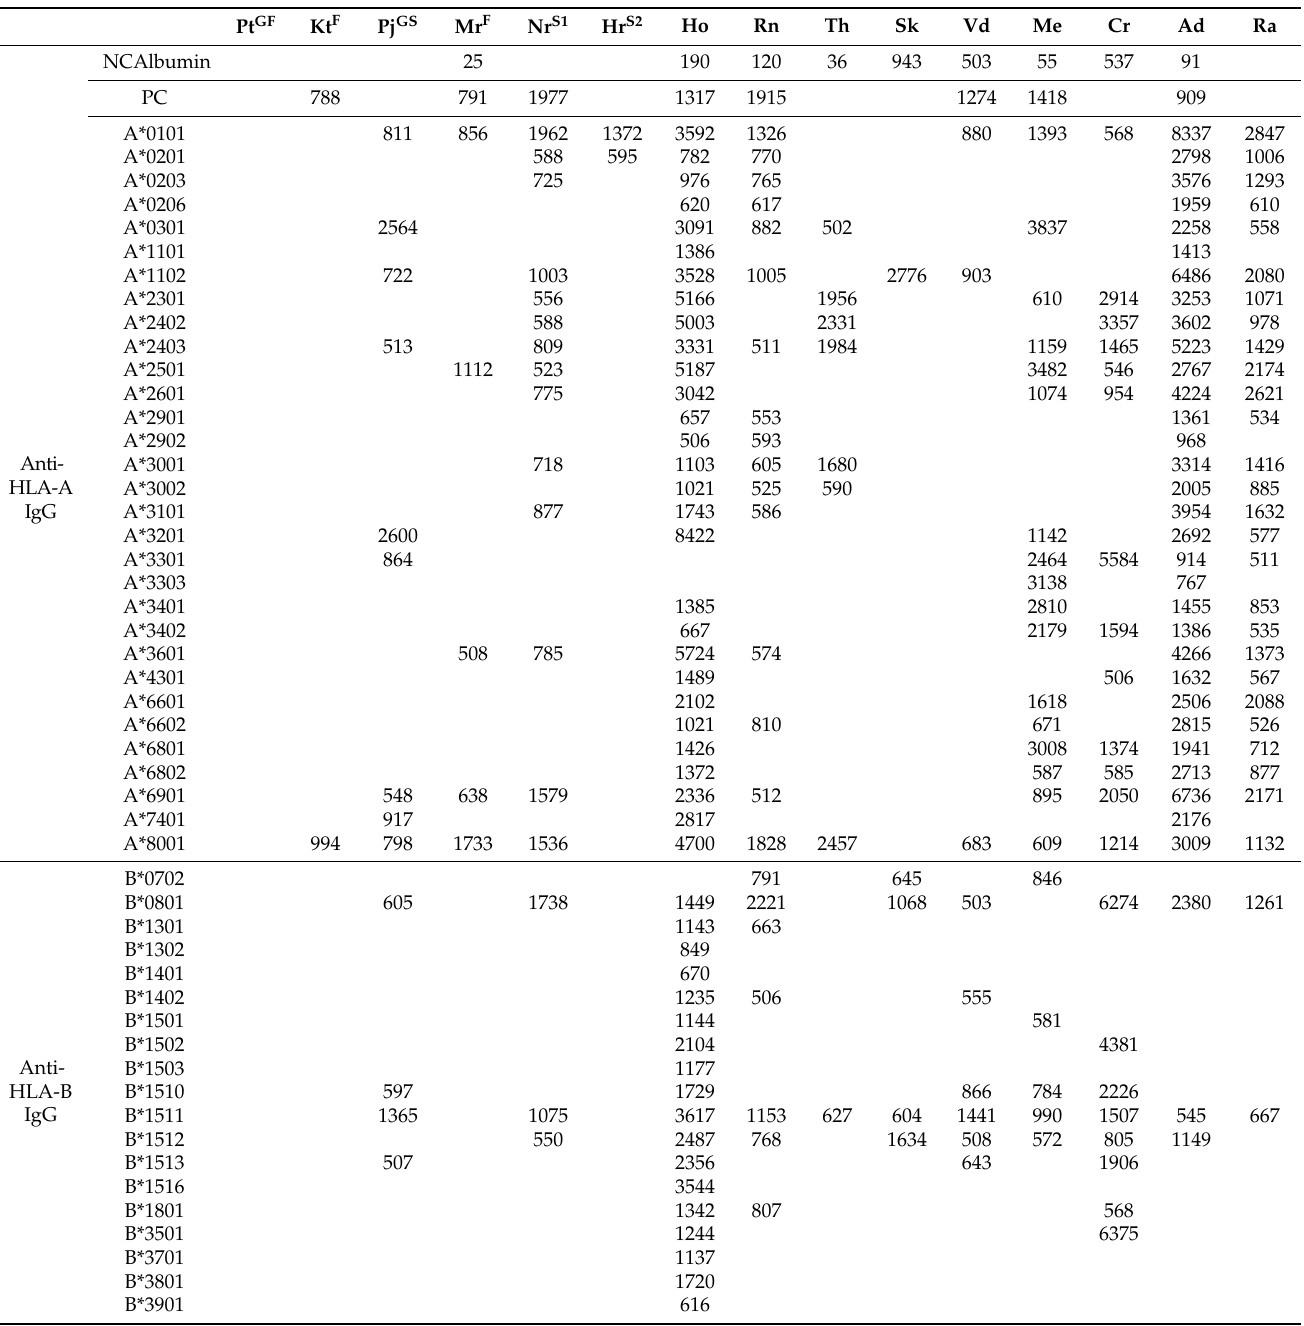
Table 4. Documentation of antibodies against HLA class Ia molecule in the sera of non-alloimmunized male volunteers. The profiles of antibodies against HLA-A, HLA-B and HLA-C differ among different individuals. Antibodies against different alleles of each HLA isomers differ as follows: HLA-C > HLA-A > HLA-B. One male (Ho) has antibodies against almost all alleles of HLA-Ia tested suggesting that the individual may possibly carry naturally occurring antibodies formed against most commonly shared epitopes such as that of 141 AYDGKDY 147 illustrated in Figure 4. No or low MFI in several individuals does not imply the absence of antibodies, as antibodies against almost all alleles can be seen after purification of IgG using the Protein-G affinity purification column as illustrated in Table 5. It implies that the naturally occurring HLA antibodies may be masked by other factors, such as anti-idiotype antibodies and immune